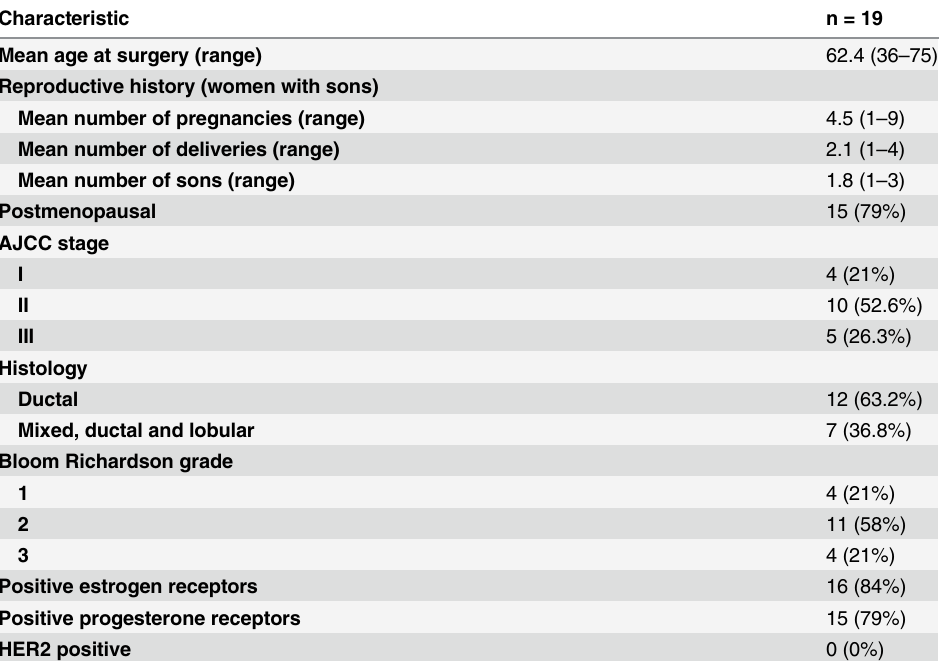
Table 1. Clinical characteristics of patients with breast